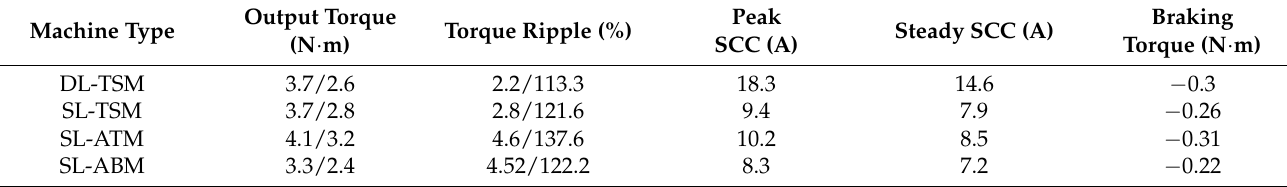
Table 4. Electromagnetic performance under single-phase short circuit